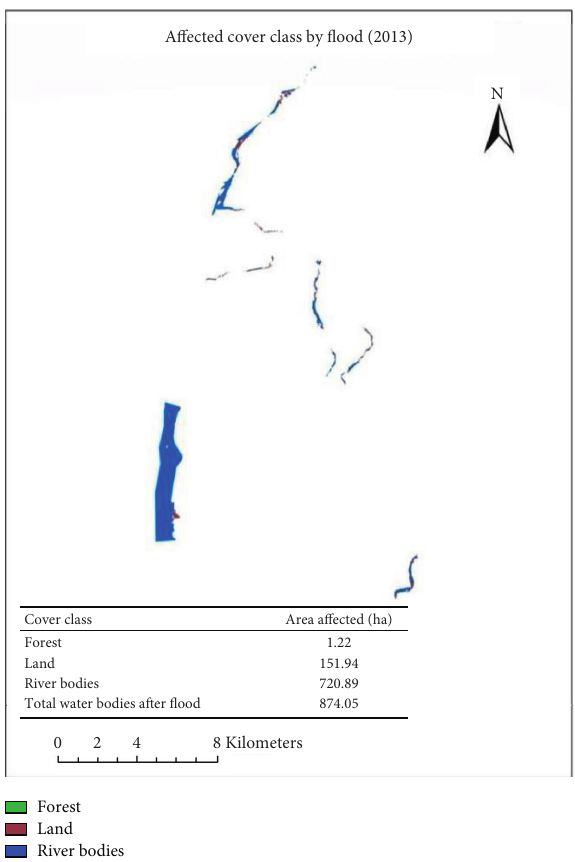
Figure 3: Affected cover class by flood